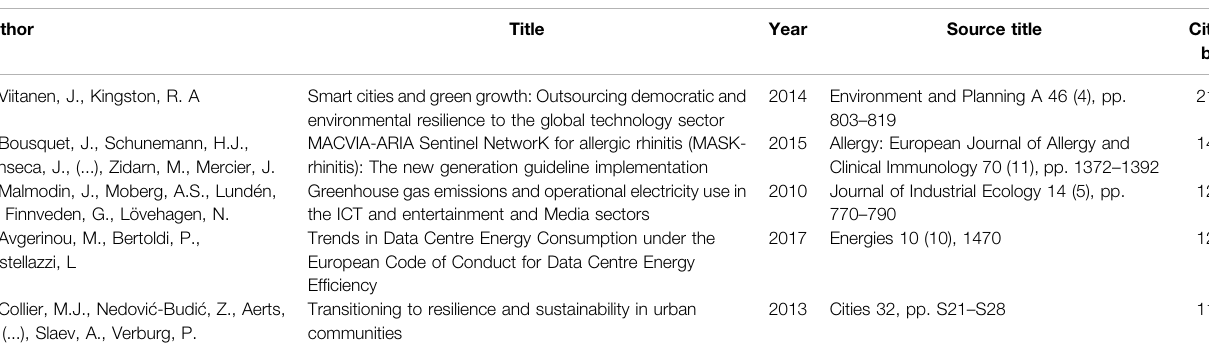
TABLE 2 | Top fi ve cited articles indexed in the Scopus